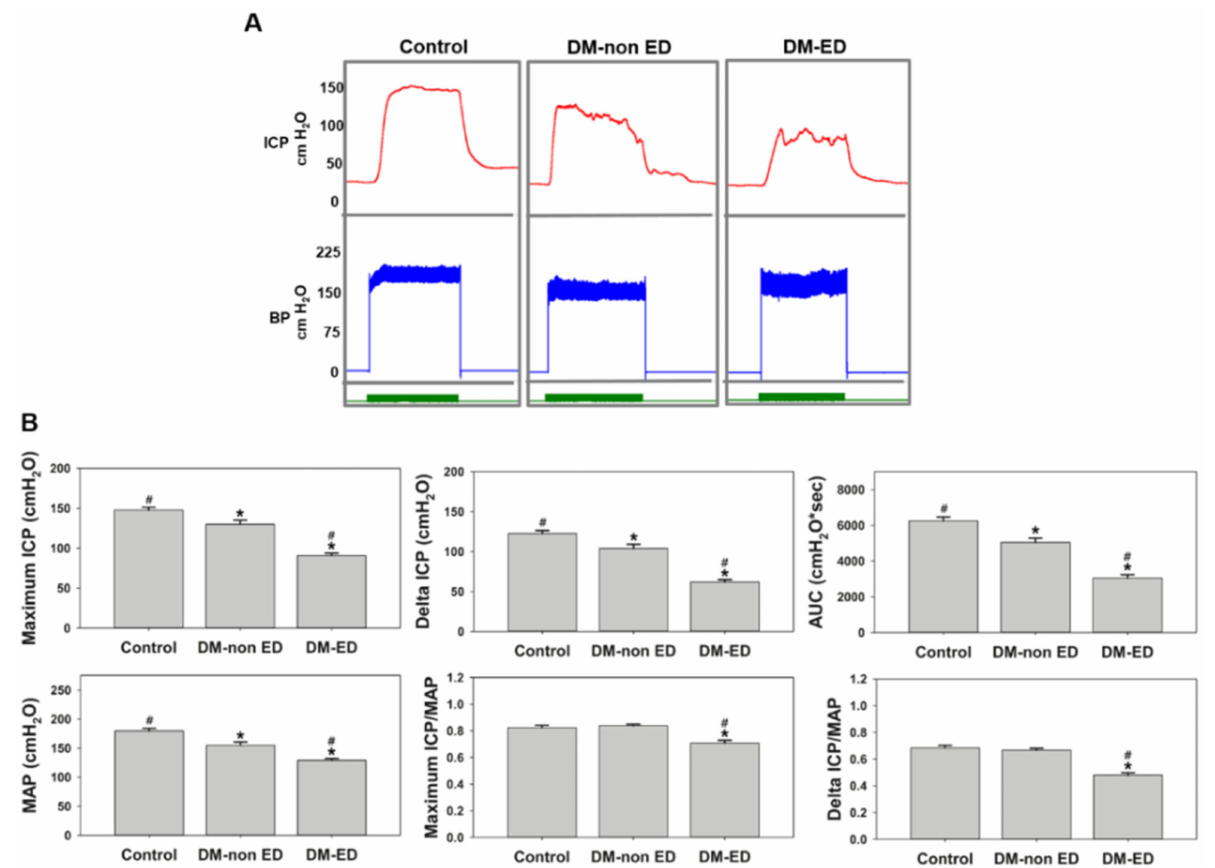
Figure 3. The erectile function parameters were compared after 12 weeks of streptozotocin (STZ) induction. ( A ) Recordings of intracavernous pressure (ICP) and blood pressure (BP) in control, DM non-ED, and DM-ED rats. ( n ≥ 8) DM-non ED, STZ-induced diabetes mellitus (DM) without erectile dysfunction (ED); DM-ED, STZ-induced DM with ED and treated with saline. ( B ) The quantitative results of an erectile function parameter (Mean arterial pressure, ICP, and AUC) were calculated for each group (control, DM non-ED, and DM-ED rats). * p < 0.05 when compared with control, # p < 0.05 when compared with DM-non ED. (AUC—area under the curve; ICP—Intracavernous pressure; MAP—mean arterial